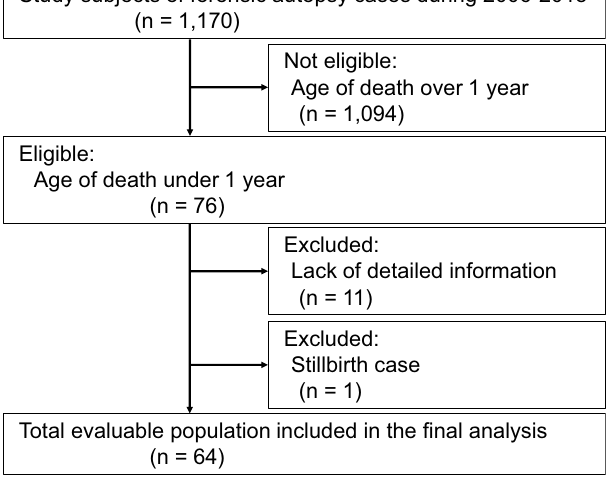
Figure 2. Flow chart of case enrollment and exclusion.